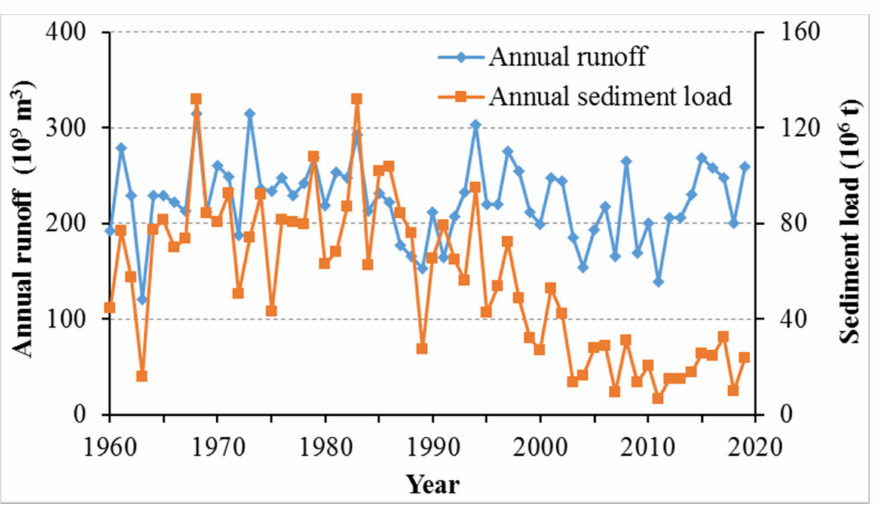
Figure 6. Changes in the annual runoff and sediment load at Makou station since